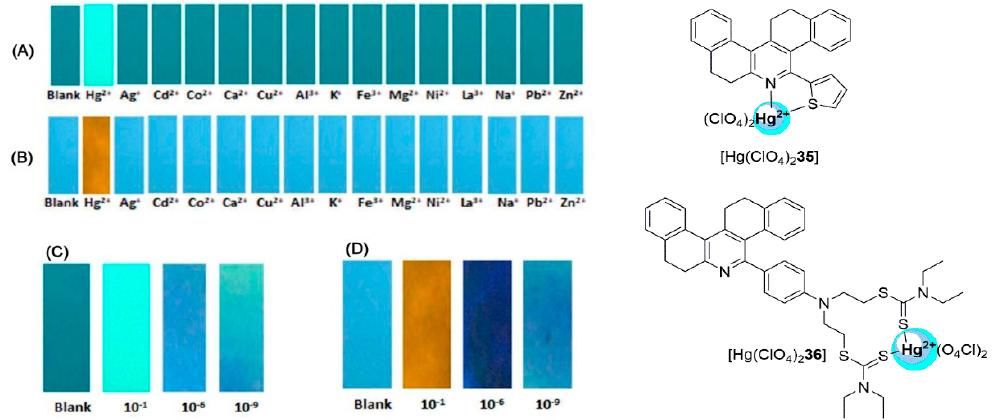
Figure 15. Changes in the fluorescence of probes 35 and 36 in paper strips with different metal ions ( A ) probe 35 ( B ) probe 36 , and at different concentration (nM) of Hg 2+ ions ( C ) probe 35 and (D) probe 36 . Adapted from [199] with permission from the Centre National de la Recherche Scientifique (CNRS) and the Royal Society of Chemistry.